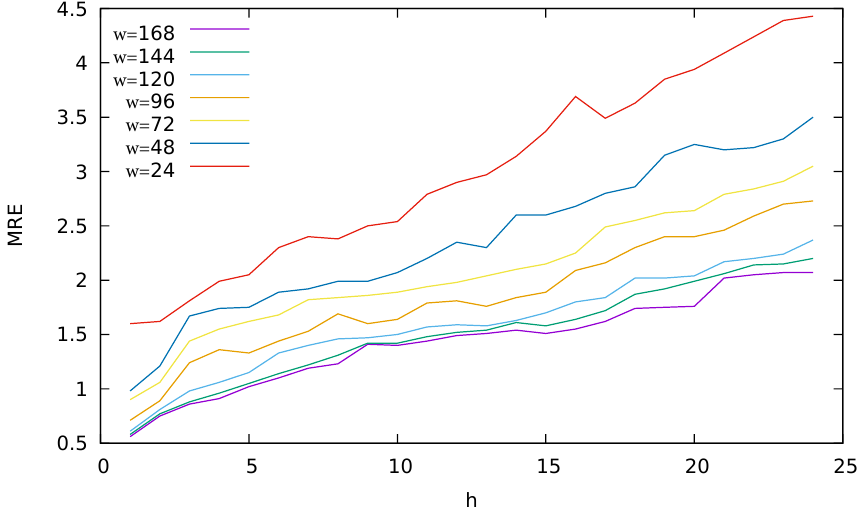
Figure 3. Results obtained for each value of h and w